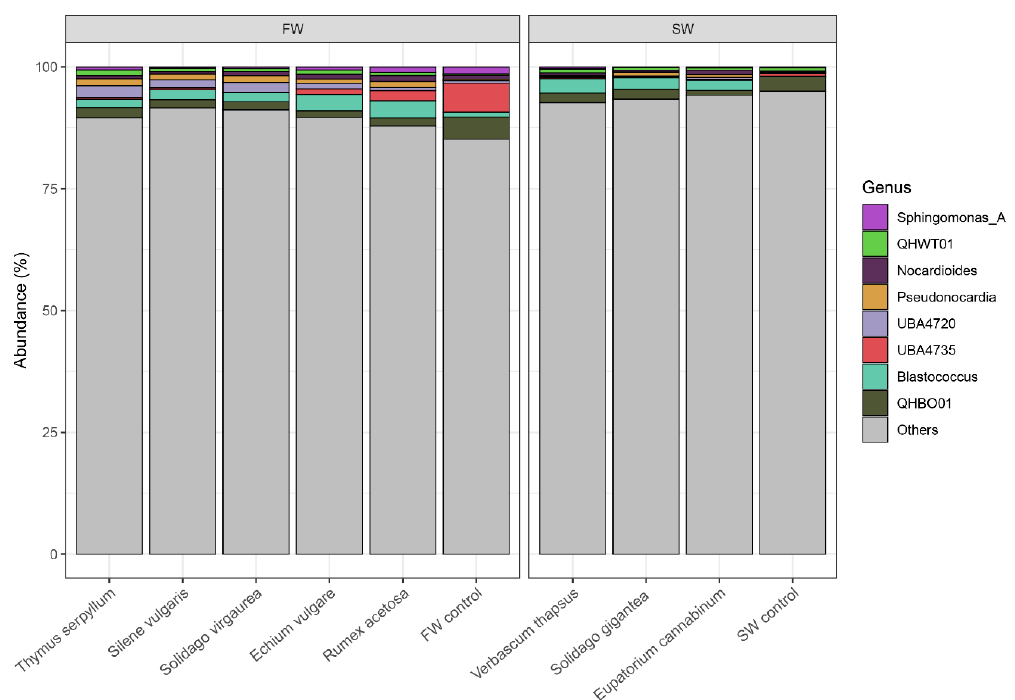
Figure 5. Most abundant genus in the root zone of the spontaneous plant species.